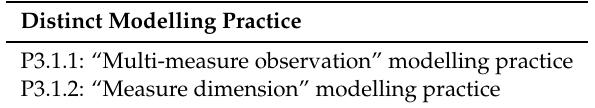
Table 29. Distinct modelling practices of data portals for multiple measures in data cubes.